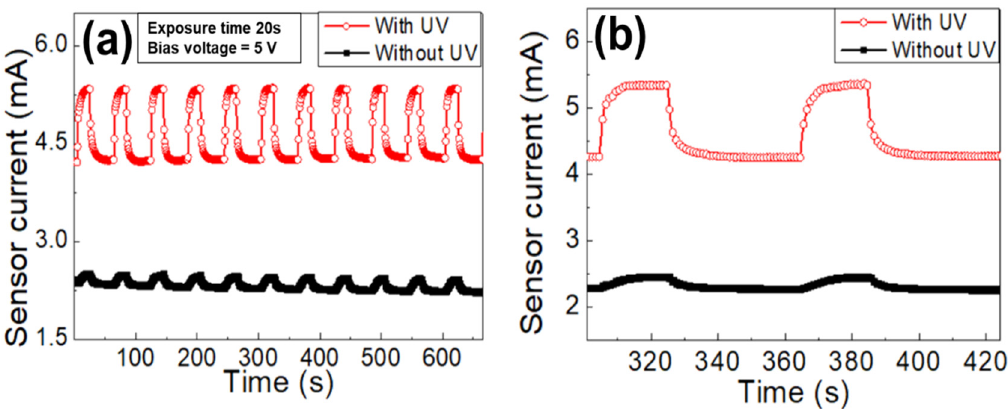
Figure 8. ( a ) Sensing repeatability characteristics of AlGaN/GaN hydrogen sensor with and without UV illumination and ( b ) zoom-in time transient characteristics.